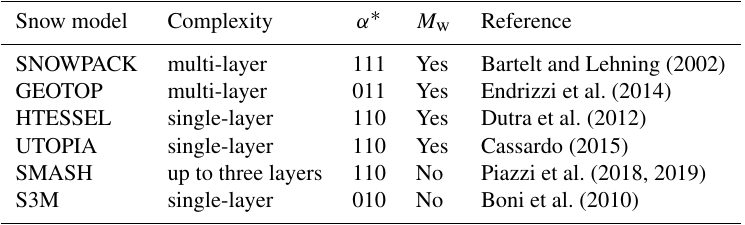
Table 1. Features of snow models in terms of model complexity following Slater et al. (2001), snow albedo ( α ) parameterization, explicit representation of meltwater retention and refreezing in the snowpack ( M w ) and a main